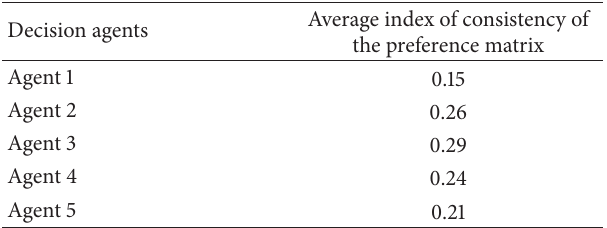
Table 3: Average index of consistency of the preference matrix. Decision